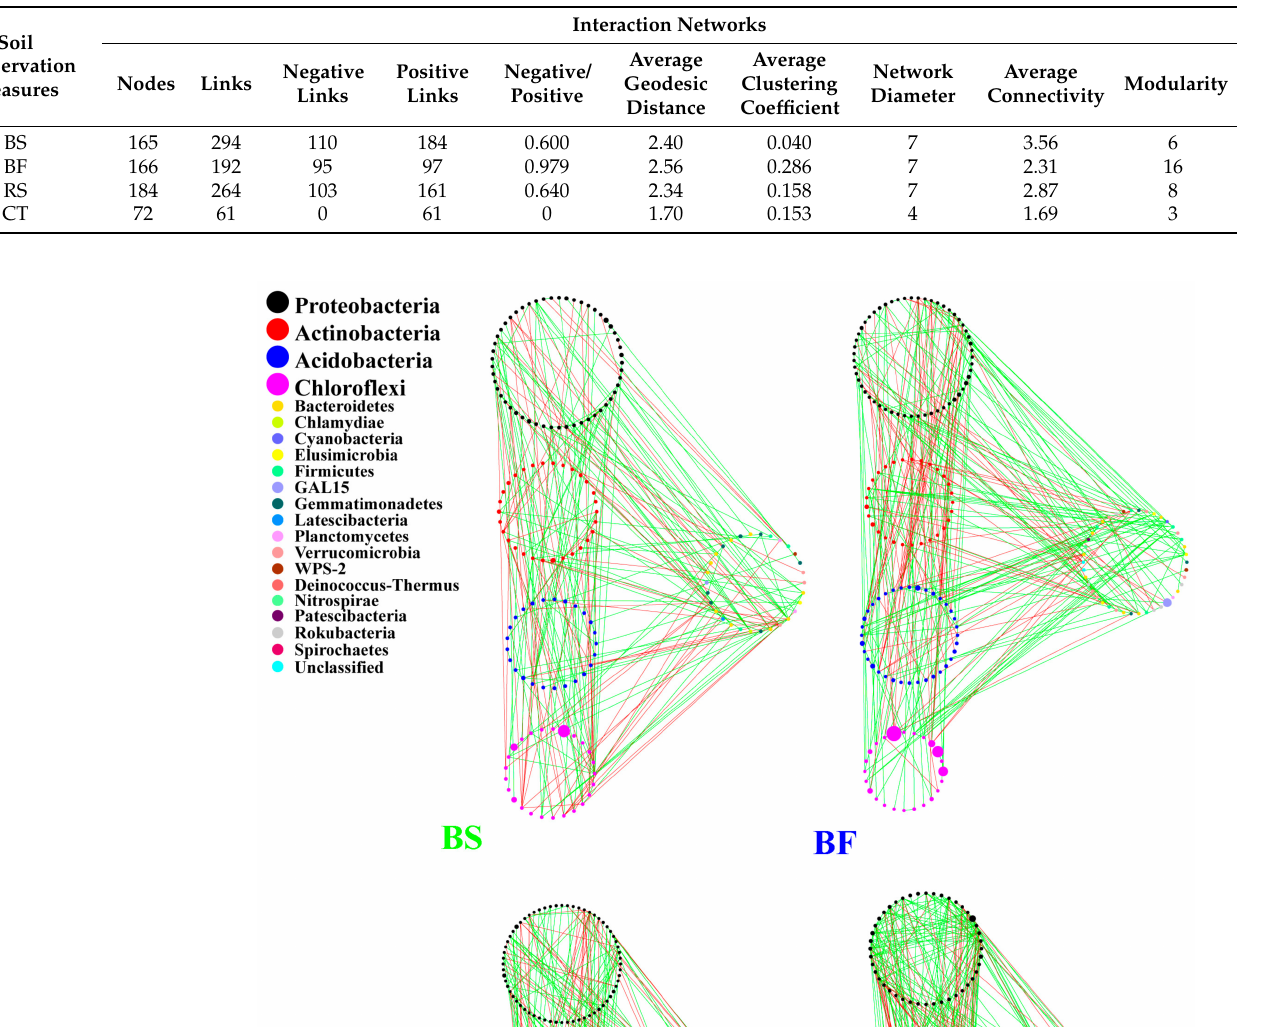
Table 4. Parameters of interaction networks of bacterial–fungal communities under different soil and water conserva- tion measures.